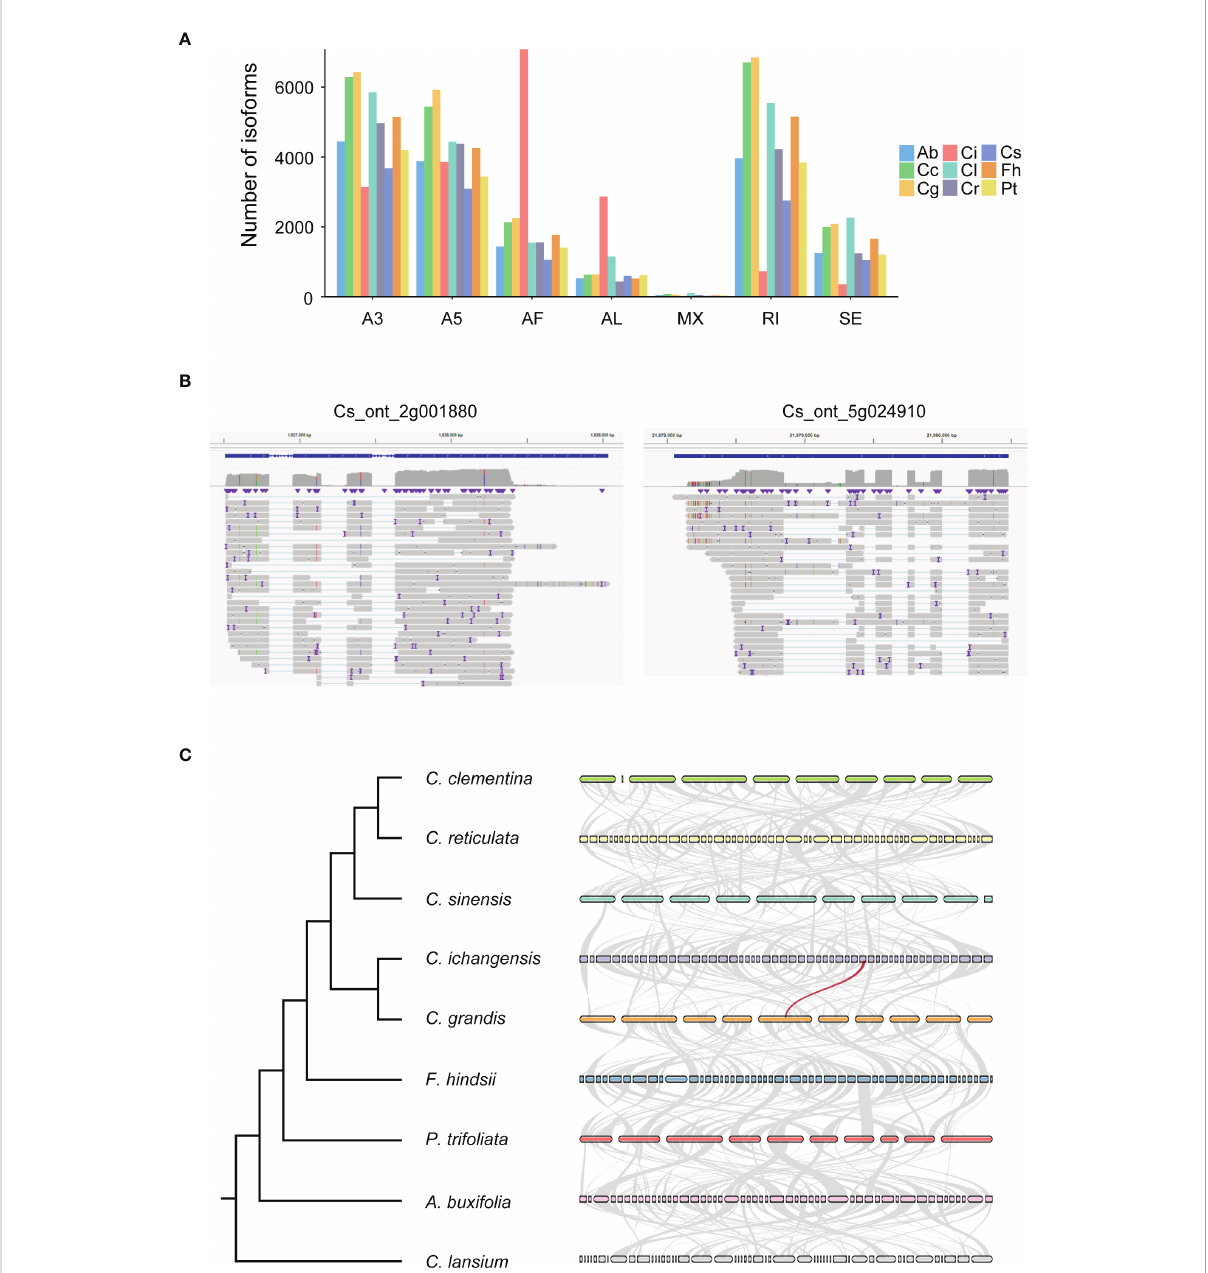
FIGURE 4 Characterization of different types of alternative splicing (AS) events and evolution of orthologous genes in 9 species. Ab, Atalantia buxifolia ; Cc, Citrus clementina ; Cg, Citrus grandis ; Ci, Citrus ichangensis ; Cl, Clausena lansium ; Cr, Citrus reticulata ; Cs, Citrus sinensis ; Fh, Fortunella hindsii ; Pt, Poncirus trifoliata . (A) AS events were predicted using SUPPA. A3, Alternative 3 ’ splice sites; A5, Alternative 5 ’ splice sites; AF, Alternative fi rst exons; AL, Alternative last exons; MX, Mutually exclusive exons; RI, Retained intron; SE, Skipping exon. (B) The full-length reads representing the complex isoforms were mapped to Cs_ont_2g001880 and Cs_ont_5g024910 , which illustrates diverse isoforms can be found by ONT RNAseq. The result was visualized by IGV. (C) A species tree generated by Ortho fi nder is shown on the left. Synteny analysis of ortholog genes among all species is shown on the right. The top 50 largest genomic fragments were used to construct the synteny network. The light grey lines indicate collinear blocks, the red line indicates ortholog single copy gene has highly abundant AS